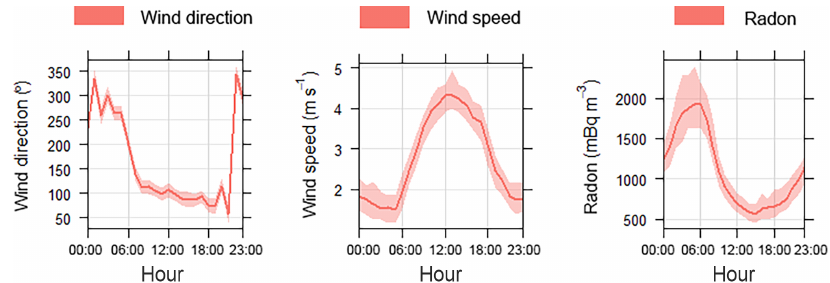
Figure 3. The observed diurnal cycles of the wind direction and wind speed at the main MUMBA site, and the radon concentration at Warrawong observed during the campaign. The shaded area shows a 95% confidence interval from a bootstrap resampling of the data. See Carslaw and Ropkins (2012) for a description of this and for calculations of the average wind direction.